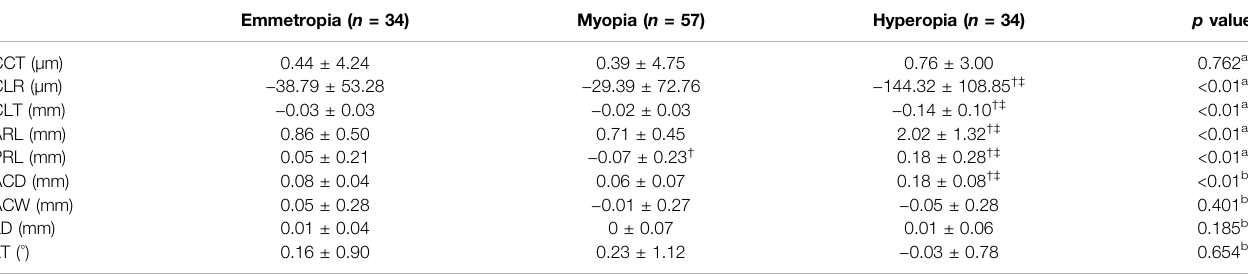
TABLE 3 | Comparison of changes in anterior segment parameters before and after cycloplegia among emmetropic, myopic and hyperopic